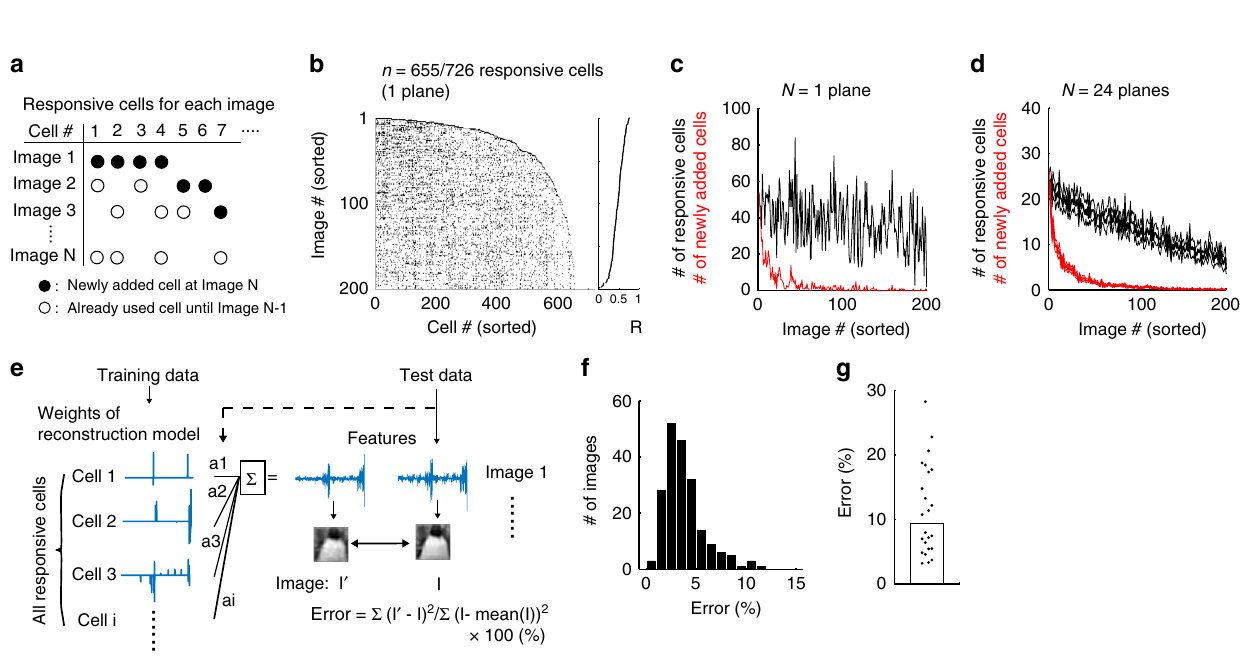
Fig. 7 Representation of multiple images in a population. a Schematic of the analysis. Responsive neurons (open and closed circles) were plotted for each image. Closed circles: responsive cells plotted for the fi rst time for image N . Open circles: responsive cells that had already been plotted for image 1 – ( N − 1). N , image number. b Raster plots of responsive cells for each image in the representative plane shown in a ( n = 655/726 responsive cells). The image #s are sorted by the reconstruction performance (right panel). For each line, cells that did not respond to the previously plotted images are added to the right side. As the image # increases, the number of newly added cells decreases, and the cell # quickly reaches a plateau, indicating that many images are represented by a combination of cells that responded to other images. c , d The number of responsive cells (black line) and of newly added responsive cells (red line) are plotted against the image # for the case shown in b , c and averaged across planes d . The number of newly added cells quickly decreases as the image # increases. Three lines in each color indicate the mean and the mean ± S.E.M. e Schematic of the analysis. The feature set of each natural image was linearly regressed by the weights of the reconstruction model (the cell-selection model) from all the responsive cells in each plane. The weights of the reconstruction model were obtained based on a training dataset, and the target image was selected from a test dataset. The fi tting error (%) was computed for each image. If the features encoded in all responsive cells were suf fi cient to represent natural images, the weights of the responsive cells should work as basis functions to represent the visual features of the natural images. f Distributions of the errors for all images in the example plane (shown in other fi gures). g The median error (%) across planes. Each dot indicates the median of each plane. d , g N = 24 planes. The stimulus image in e is adapted from the database in ref. 57 with permission. Source data are provided as a Source Data fi During image presentation, one image type was consecutively fl ashed three around centers of the original images. Some original images were downsampled times (three 200 ms presentations interleaved with 200ms of a gray screen), and before the extraction of the center parts. We selected 200 images that had spatial the presentation of the next image was initiated after the presentation of the gray structure for the fi nal stimulus set and did not include images that had less spatial screen for 200ms. Images were presented in a pseudorandom sequence, in which structure (e.g., almost fl at image) and very high SF components throughout the each image was presented once every 200 image types. Each image was presented at image (e.g., fi ne texture) by visual inspection. The pixel-to-pixel correlation least 12 times (i.e., 12 trials) for anesthetized and ~40 times for awake mice in the between images was 0.003 ( − 0.12 – 0.11) (median (25th – 75th percentile), n = 200 entire recording session for one plane. We did not set a long interval between images).